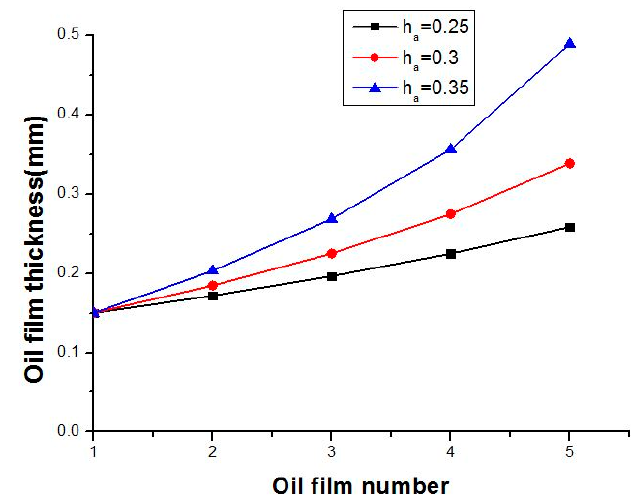
Figure 4. Oil film thickness distribution with different h a .